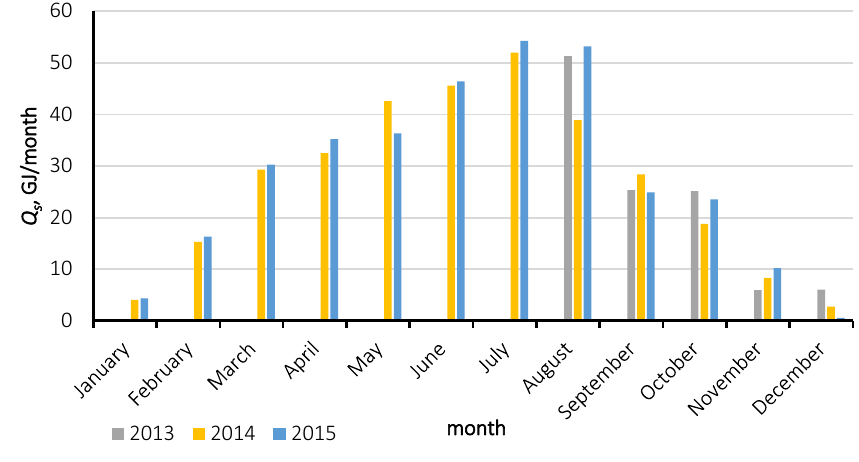
Figure 5. Monthly values of solar heat gains ( Q s ) obtained from the installation in Brzesko from